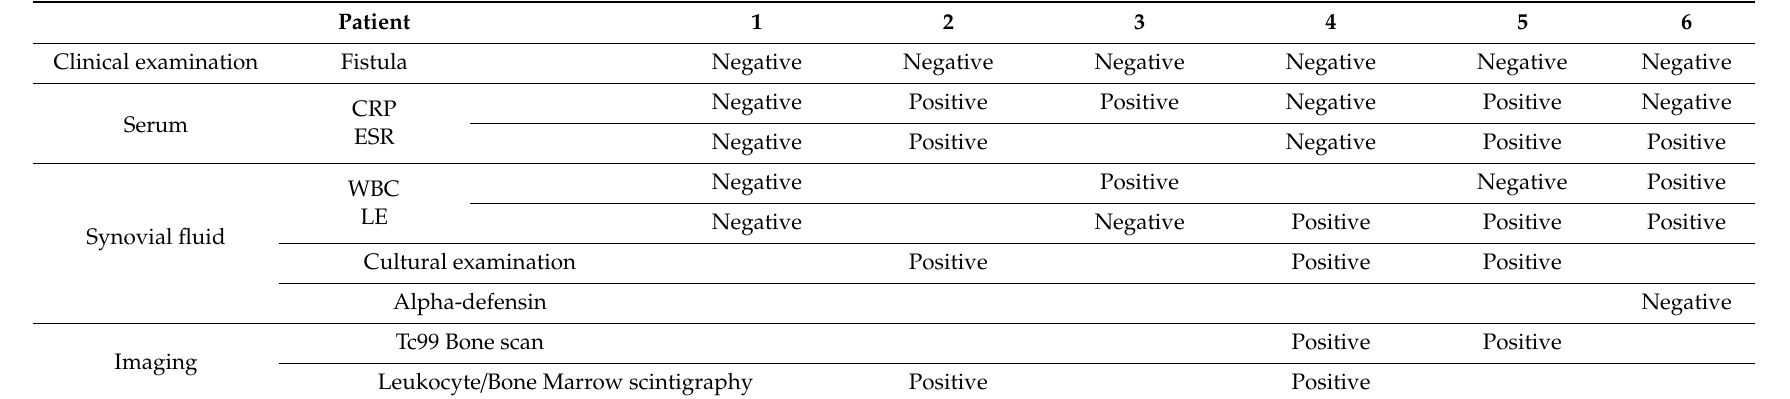
Table 7. Tests results of post-operatively not confirmed pre / intra-operative definitions. One patient (Case 1) defined as No Infection did show a positive histological finding, while the remaining 5 patients (Cases 2 to 6) were classified as low-grade PJI based on pre-operative tests, but were all negative at histological and cultural examination at